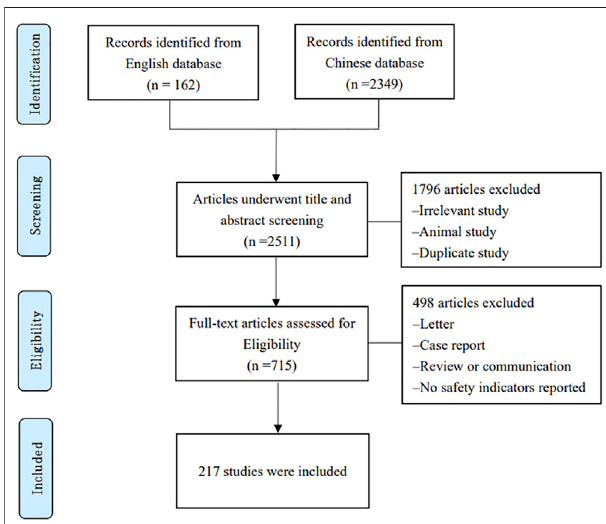
FIGURE 1 | Flow chart of the search and selection